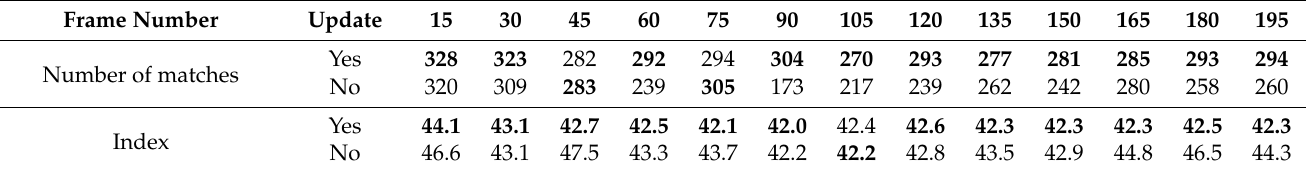
Table 7. Comparison of the number of matching points and index values. The better results are highlighted in bold.